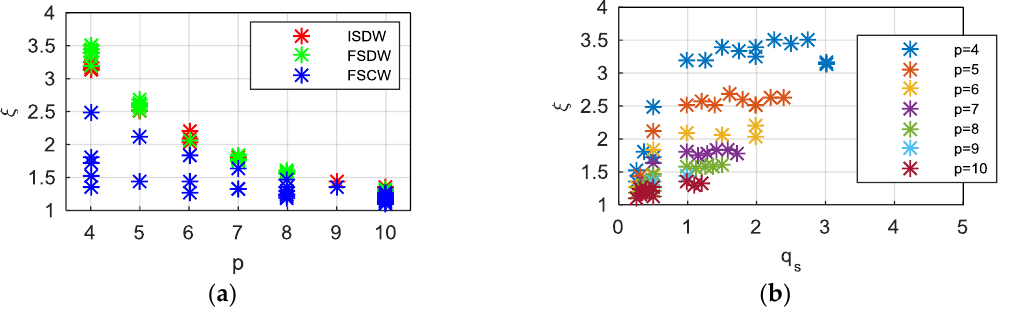
Figure 22. Saliency ratio ( ξ ) versus ( a ) pole pair number ( p ) and winding type; ( b ) stator slot number per pole and phase ( q s ) and pole pair number ( p ).